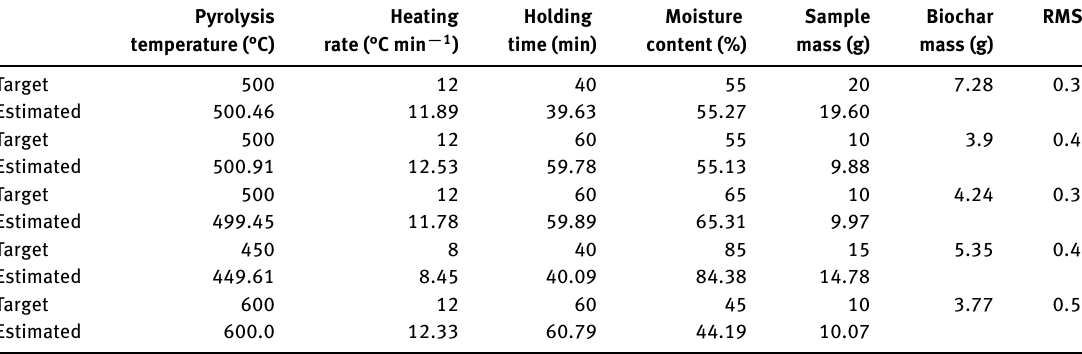
Table 7: Estimating the Values of Input